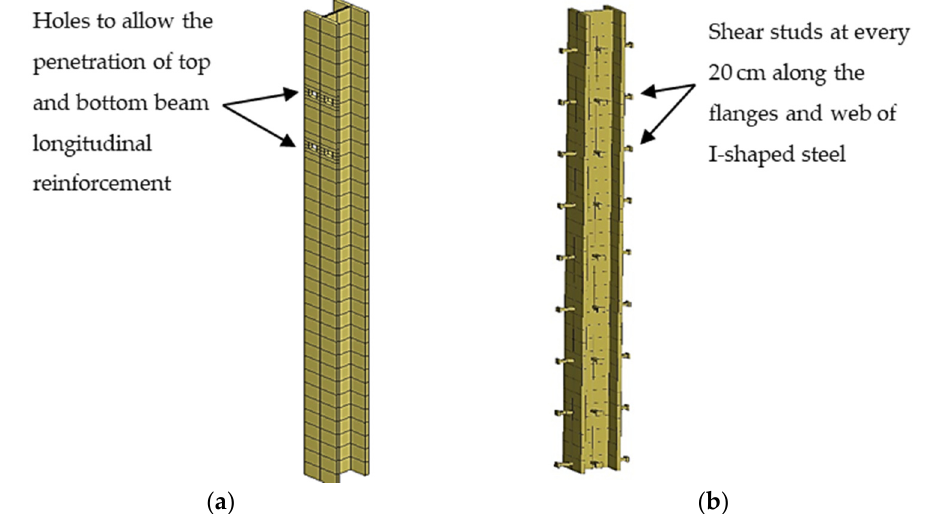
Figure 7. Structural steel section models: ( a ) Without shear studs; ( b ) with shear studs.